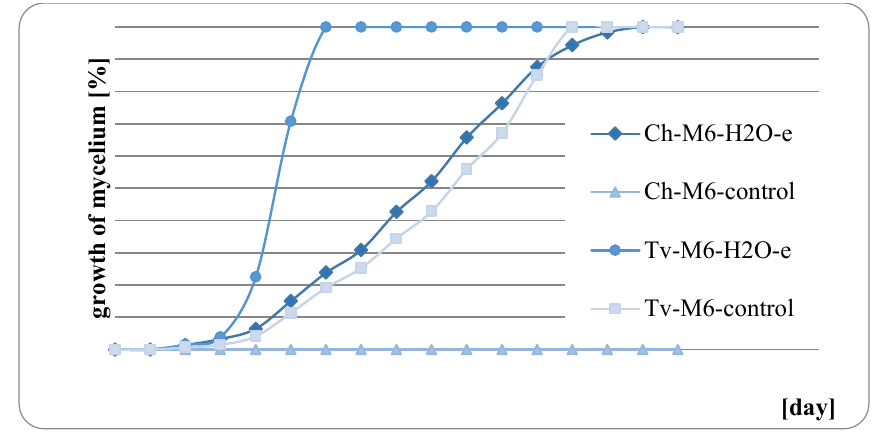
Figure 11. Growth of fungi on M. × piperita ‘Almira’ with and without extraction.